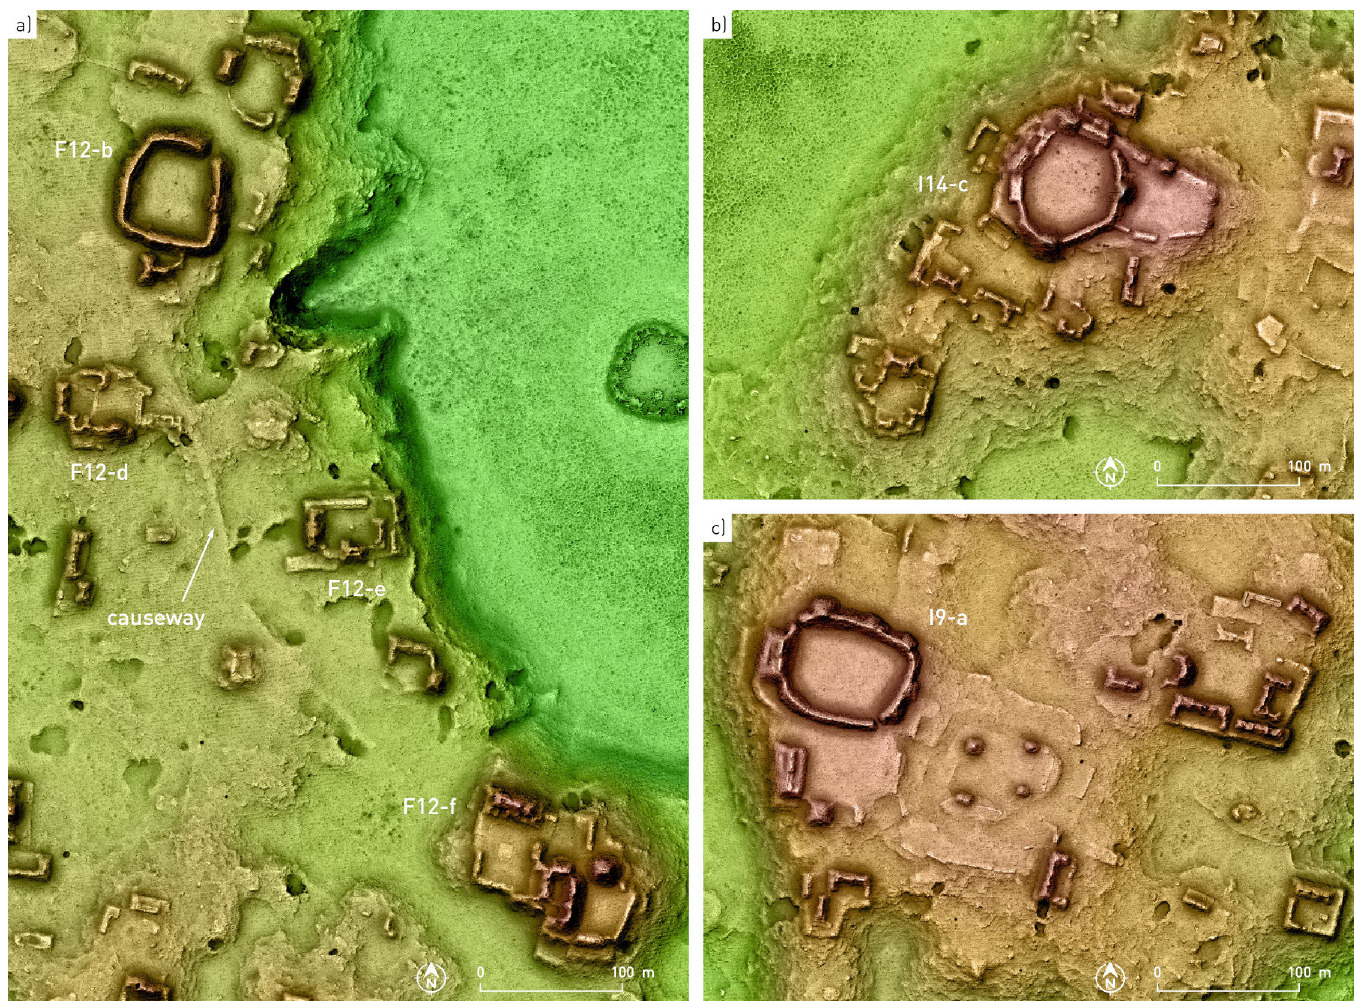
Fig 6. Settlement clusters with Pechal-type